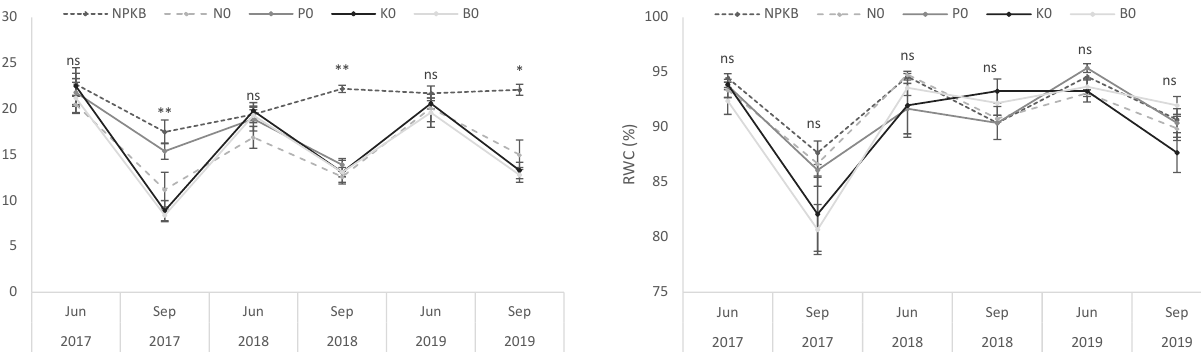
Figure 3. Net photosynthetic rate (A) and relative water content (RWC) of leaves from olive trees supplied with NPKB (control) and without N (N0), P (P0), K (K0) and B (B0) in two periods of 2017, 2018 and 2019. Vertical bars represent the standard errors.